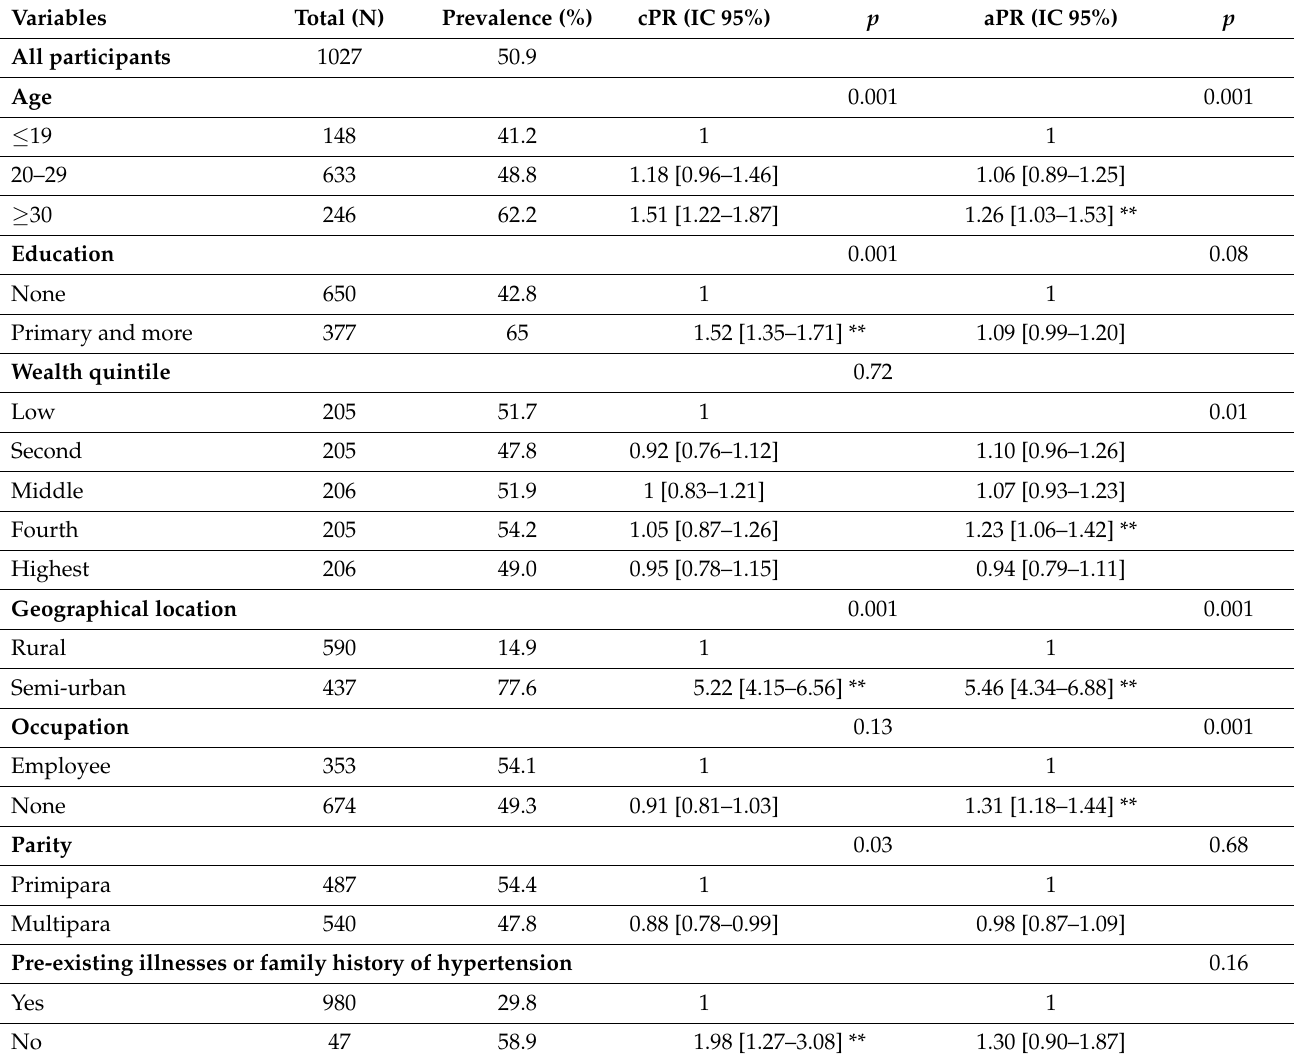
Table 6. Factors associated with the presence of more than one cardiovascular lifestyle risk factor in rural and semi-urban Burkina Faso,